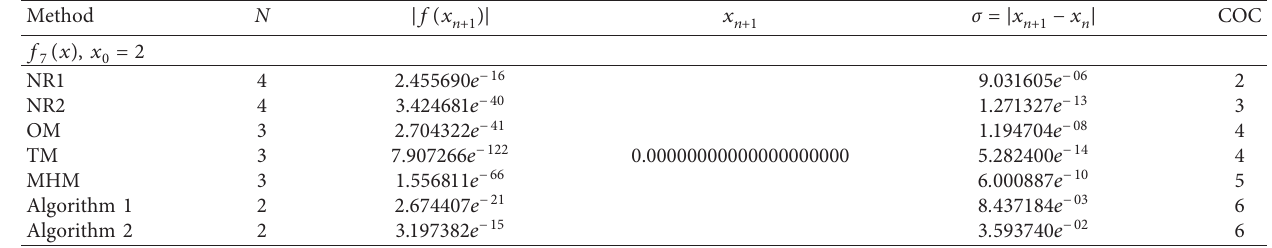
Table 7: Comparison of various iterative methods.